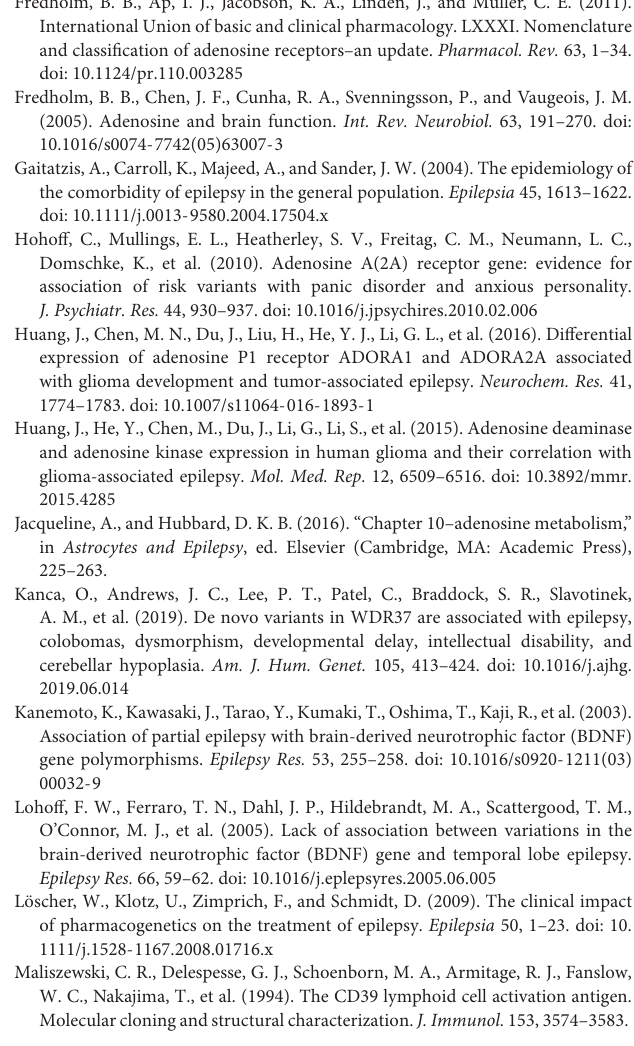
Supplementary Table 2 | Functional enrichment analysis of fourteen ADORA2A target